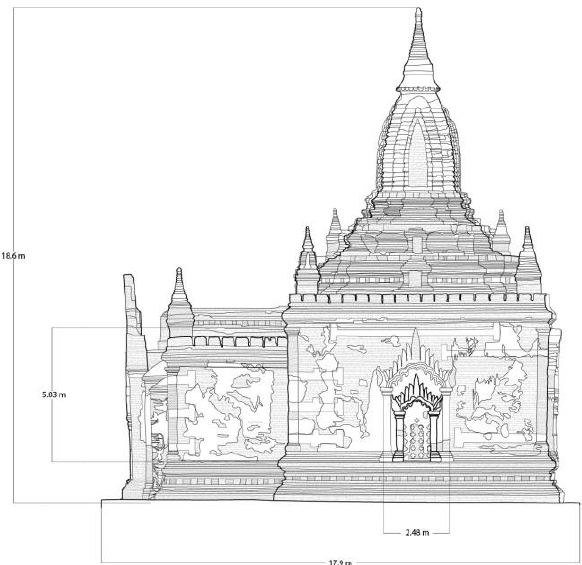
Figure 12: Drawing of West façade of Loka-Hteik Pan temple. Source: Authors.